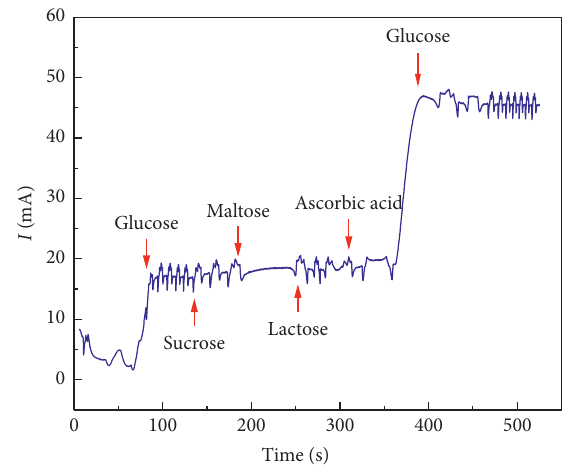
Figure 9: Interference examined in the Cu-CuO/PANI/316L sensor in 0.1 M NaOH solution with 1 mM glucose and 1 mM of interferents (sucrose, maltose, lactose, and ascorbic acid).